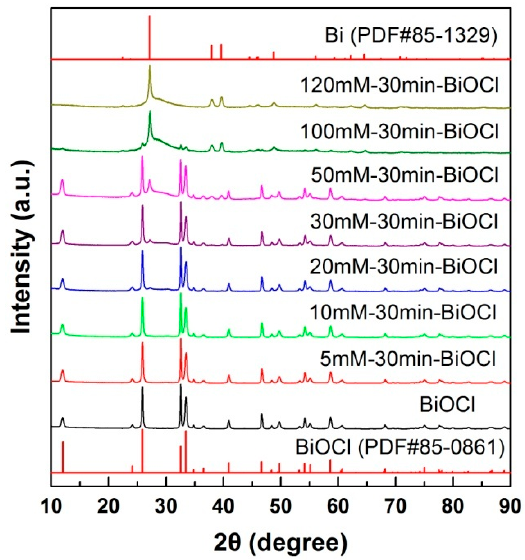
Figure 1. X-ray powder diffraction (XRD) patterns of pristine and NaBH 4 -treated BiOCl samples with different concentrations (reaction time 30 min).